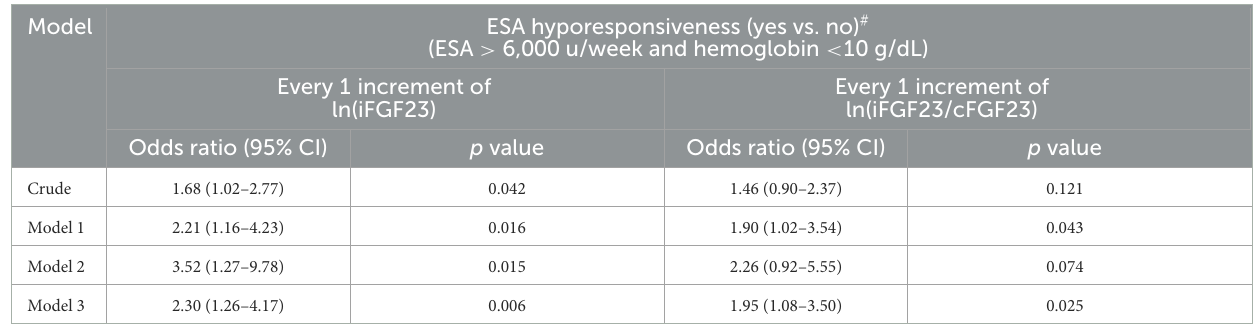
TABLE 5 Association between FGF23 and ESA hyporesponsiveness in patients on chronic hemodialysis.